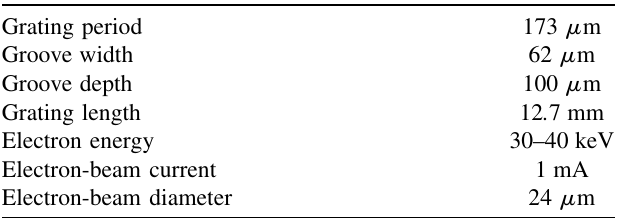
TABLE I. Parameters of the Dartmouth experiment. Grating